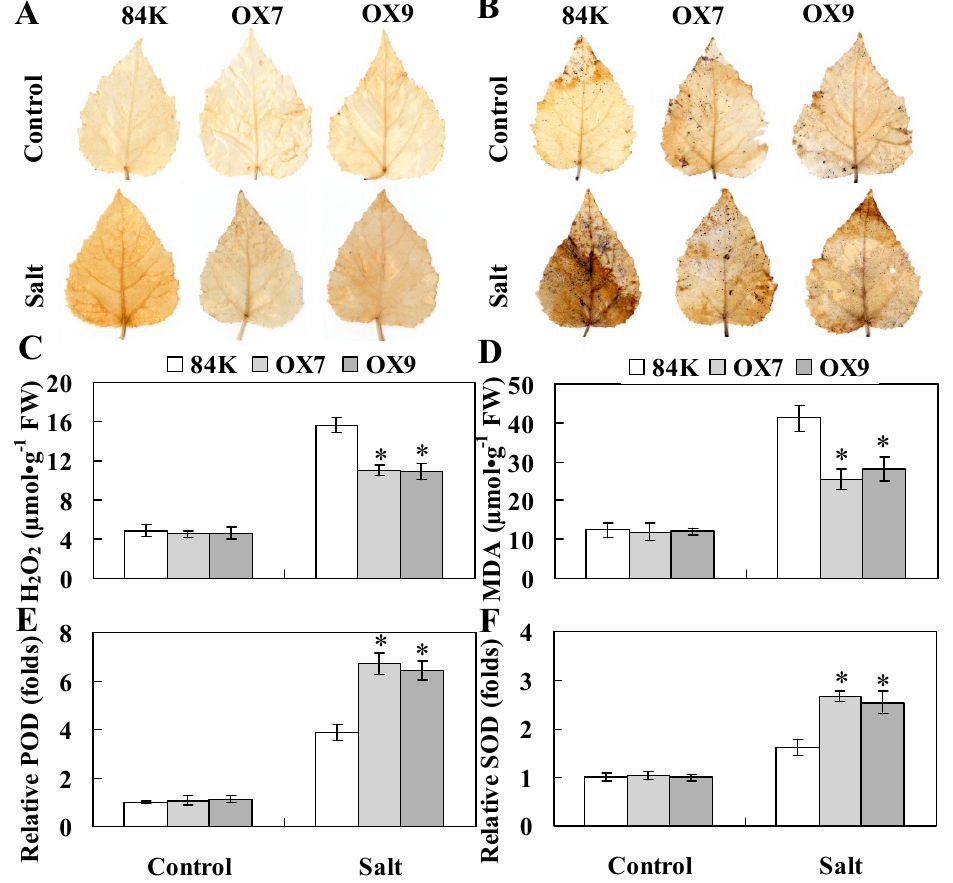
Figure 6. ThHSFA1 enhances ROS scavenging capability of transgenic poplar plants under salt stress. Leaves were collected from nontransgenic 84K and transgenic poplars before and after salt stress and used for histochemical staining including DAB ( A ) and NBT ( B ) staining, and physiological analyses, including measurements of H 2 O 2 ( C ) and MDA ( D ) content and relative POD ( E ) and SOD ( F ) activity levels. Poplar plants were cultivated and subjected to salt stress (200 mM NaCl) every 2 days for 10 days as described in Figure 4. The error bars represent ± SD from multiple biological replicates, and the asterisks indicate significant differences between nontransgenic 84K and transgenic plants (*, p < 0.05).